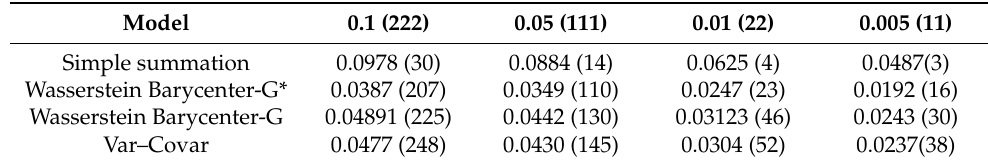
Table 3. VaR for t = 751 to 2971, number of exceptions (in brackets), where the estimated VaR was exceeded by the portfolio loss, with α =